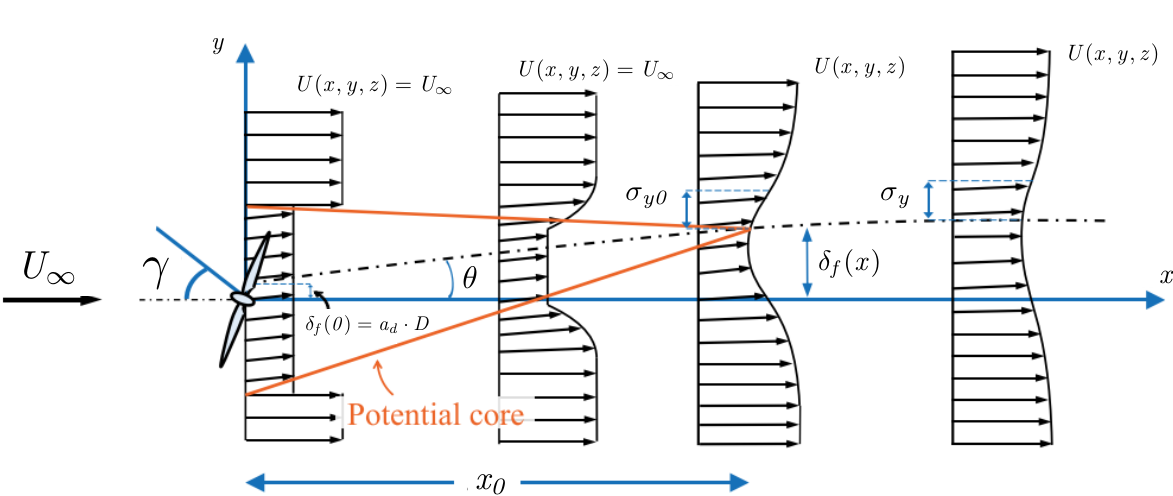
Figure 2. Schematic overview of the wake of a yawed turbine (a negative misalignment angle is shown). Originally taken from Bastankhah and Porté-Agel [44] and modified by Doekemeijer et al.